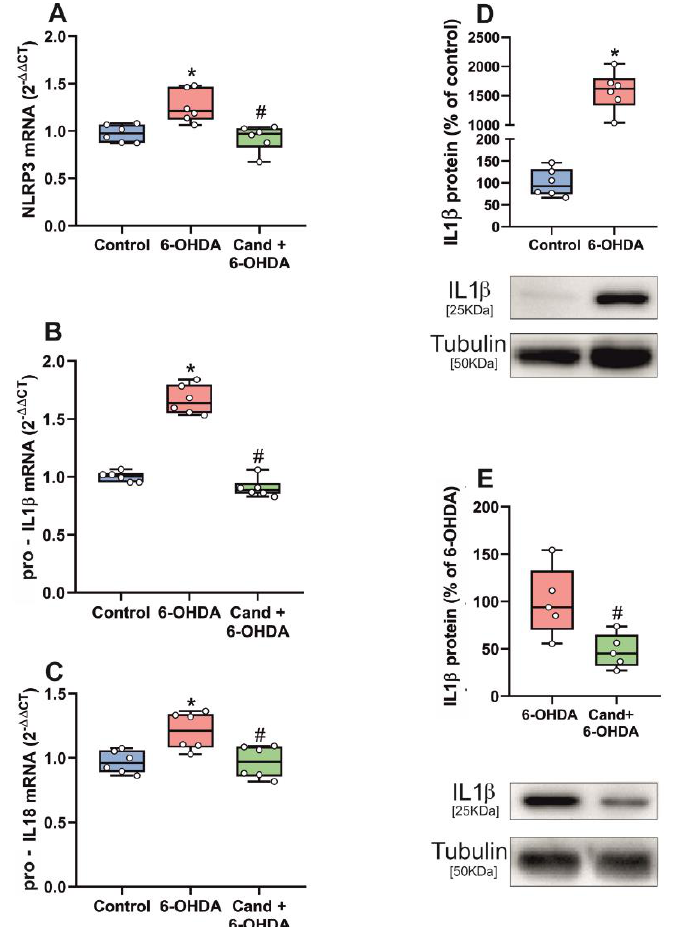
Figure 5. qRT-PCR and WB analysis of expression of NLRP3 inflammasome markers in primary cultures of ventral mesencephalon treated with 6-OHDA. 6-OHDA significantly increased mRNA expression of NLRP3 inflammasome markers ( A – C ) and protein expression of IL1 β ( D ) in 6-OHDA treated cultures. Candesartan significantly prevented upregulation of the mRNA expression of the inflammasome markers ( A – C ) and protein expression of IL1 β ( E ). To determine the relative mRNA expression of each gene of interest vs. the β -Actin housekeeping transcripts, we used the comparative Ct values method (2 − ∆∆ Ct ). Protein expression was determined relative to the α -tubulin band value and normalized to the control values (100%). Data distribution is shown using box plots with boxes representing the Interquartile range (IQR) and the median and whiskers representing the maximum value (upper whisker) and the minimum (lower whisker). * p < 0.05 relative to control rats; # p < 0.05 relative to 6-OHDA treated rats.